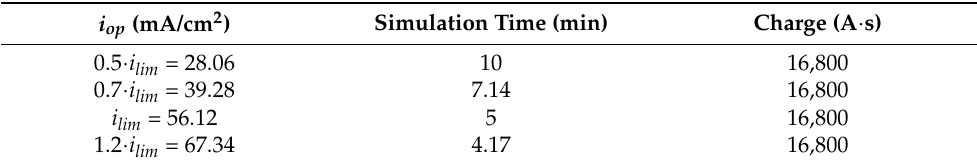
Table 1. Values of current density, simulation time and transported charge considered for the simulation of continuous galvanostatic electrodialysis (ED) in the present work.